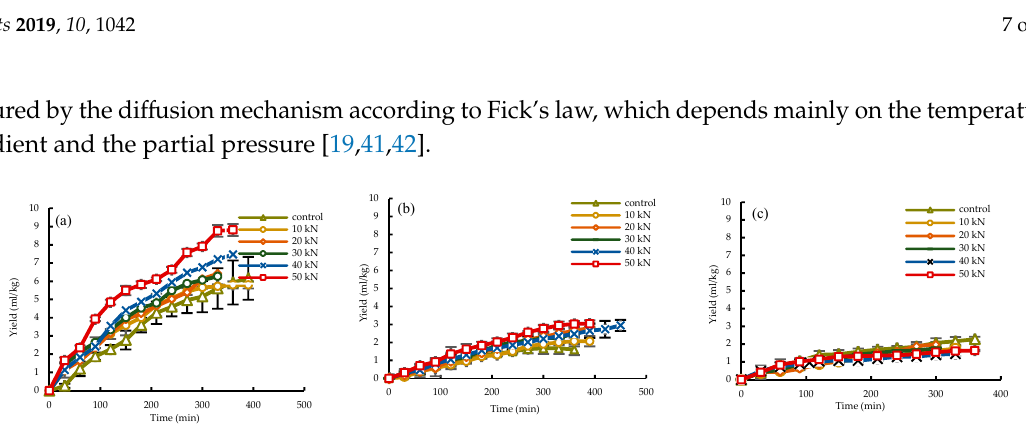
Figure 3. The yield of EOs extracted by hydrodistillation from residual forest biomass densified into bundles for ( a ) BF, ( b ) BS, and ( c ) JP.